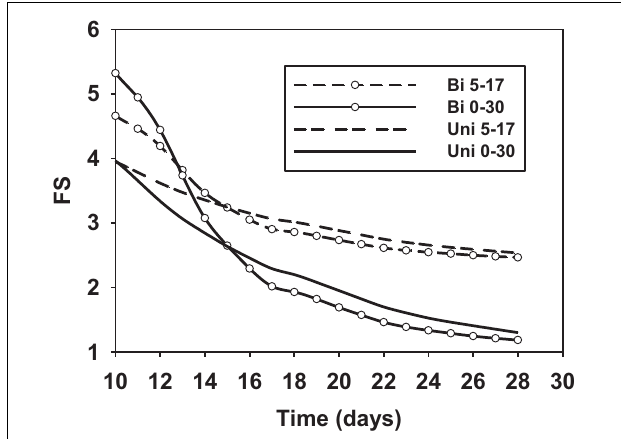
FIGURE 11 | Factors of safety using the bimodal and unimodal hydraulic properties, where, the “Bi” and “Uni” represent the Bimodal and Unimodal functions, respectively, the following pair of numbers represent the values of cohesion (kPa) and internal friction angle ( ◦ ), respectively.